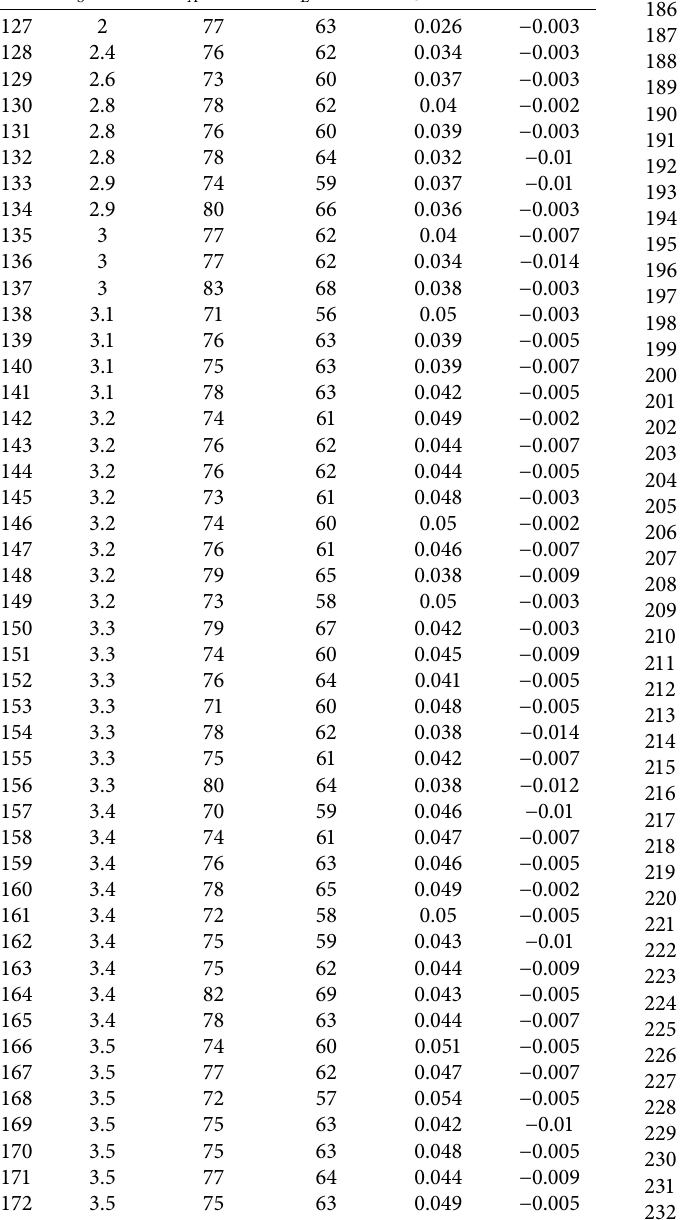
Table 3: The sinking velocity and correlated parameters sample for IK-RSM